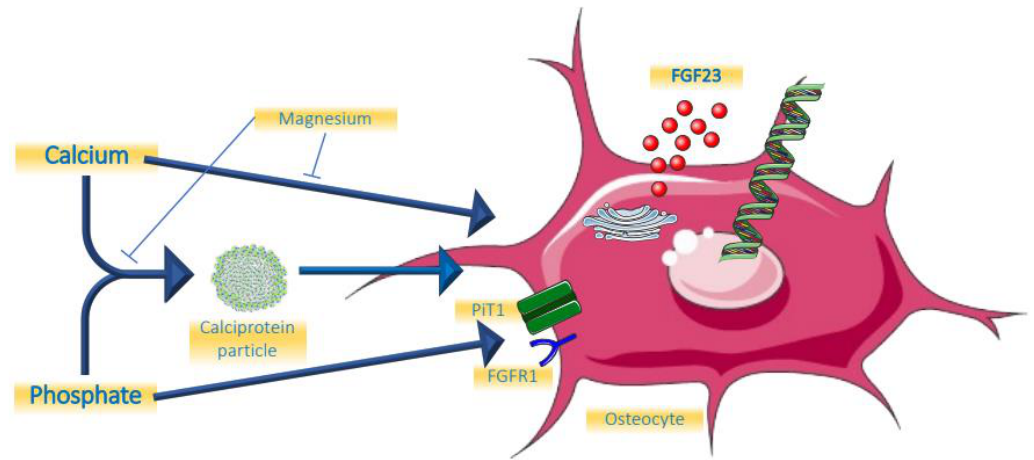
Figure 1. Effects of minerals on FGF23.